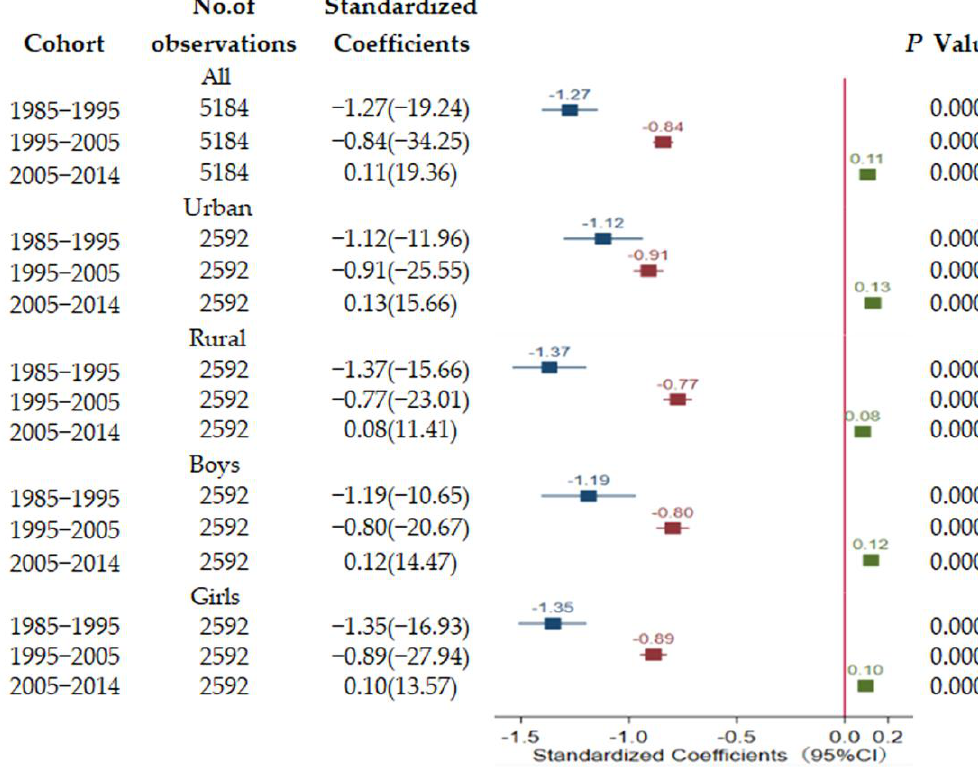
Figure 5. Longitudinal association of urbanization ratio with lung function.